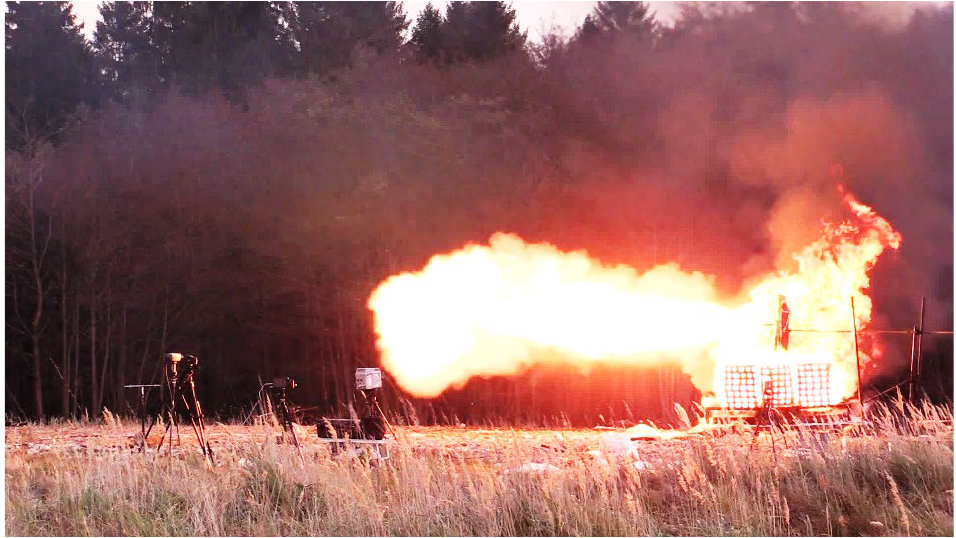
Figure 8. Controlled destruction of pressure cylinder (fire jet). During the tests, the temperature on the shell of the cylinders and the internal pressure were measured and recorded. In particular, the pressure was important for the compar- ison of these two effects. There was a noticeable difference between these two types of destructions. Uncontrolled destruction caused immediate pressure drop and the content was released after the disruption of the cylinder shell. The destruction pressures for uncon- trolled destruction were 61.2, 49.9 and 55.0 bar with times of failure of 450, 400 and 500 s. Compared to that, after penetration of the cylinder shell, the content was released with a declining trend in several seconds. The destruction pressure was achieved after 6 min in direct fire. The time for shell penetration was derived based on practical experience. Regardless of the time of the acetylene cylinder in the fire, if 35 bar was achieved, the controlled destruction was performed. The pressures in the time of shooting were 37.1, 38.7 and 38.5 bar. The controlled destruction in the times of failure were 373, 366 and 395 s. After penetrating the cylinder shell, there was no risk of physical